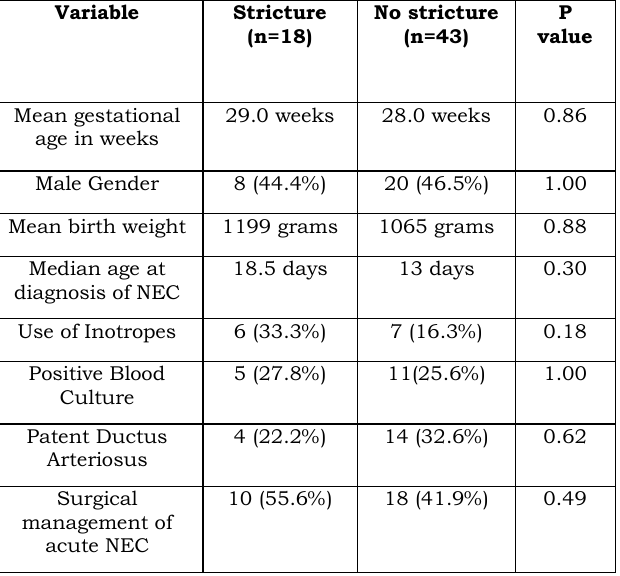
Table 1: Baseline